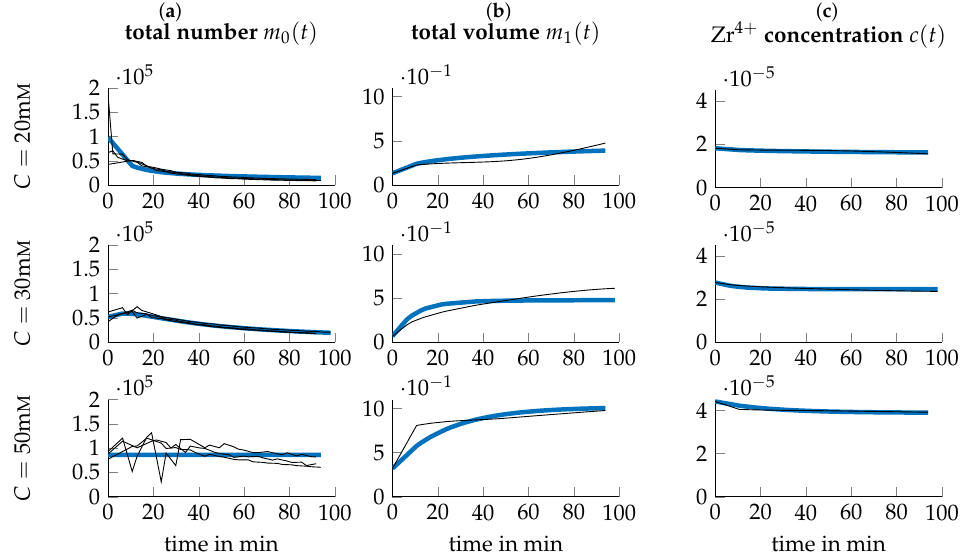
Figure 2. Data (black thin lines) and simulation (blue thick lines) for T = 40 ◦ C and different precursor concentrations C . Data obtained like in Figure 1.